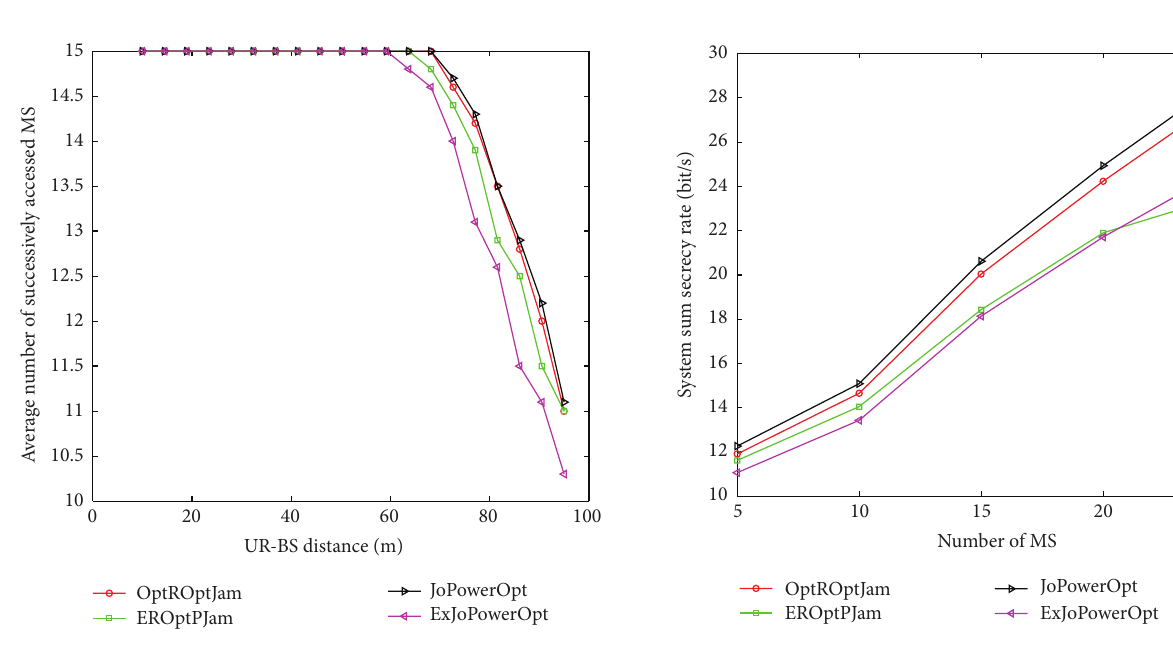
Figure 5: Number of successively accessed MS versus UR-BS distance.